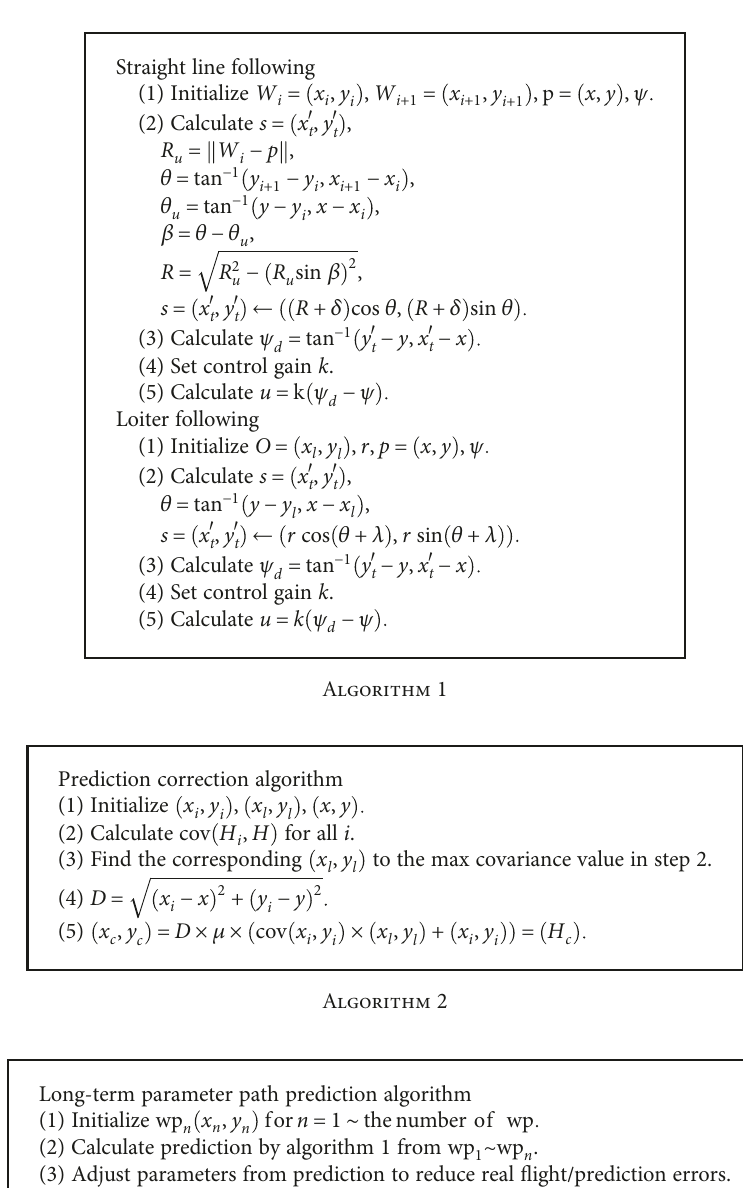
Figure 7 is the actual recording of an UAV fl ight trajec- tory in Southern Taiwan airspace, the red circles indicate the waypoint the UAV is subjected to follow, and the blue dots are the GPS fl ight logs with an interval of 1